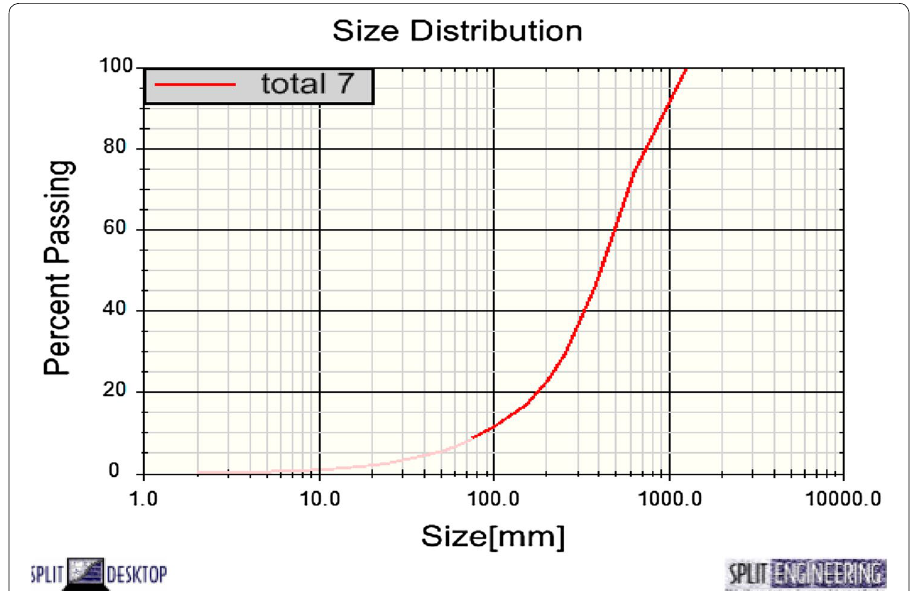
Fig. 3 Final cumulative grain-size curves of block no. 3